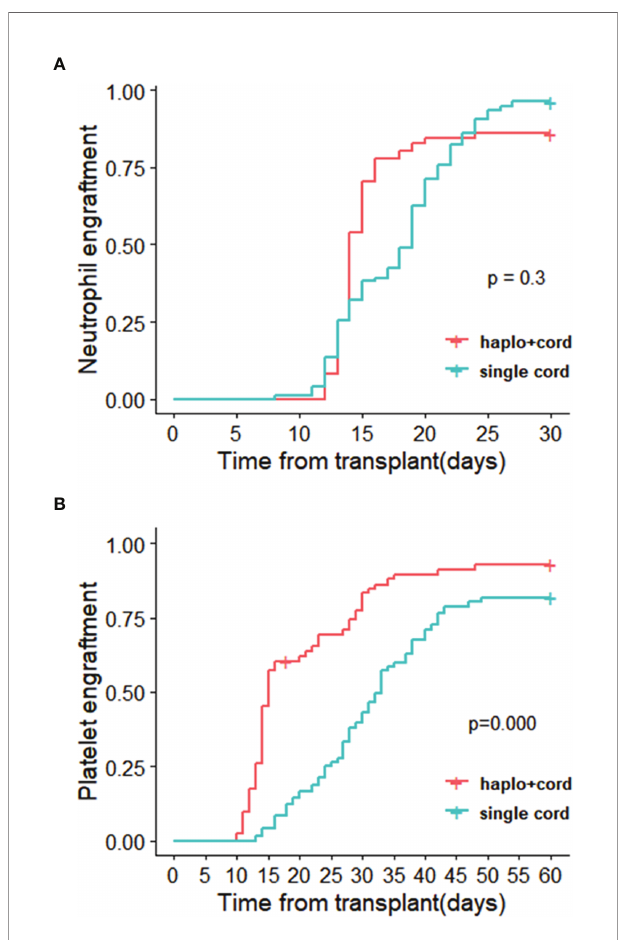
FIGURE 3 | Cumulative incidences of (A) neutrophil recovery and (B) platelet recovery in haplo-cord HSCT and single cord HSCT group after